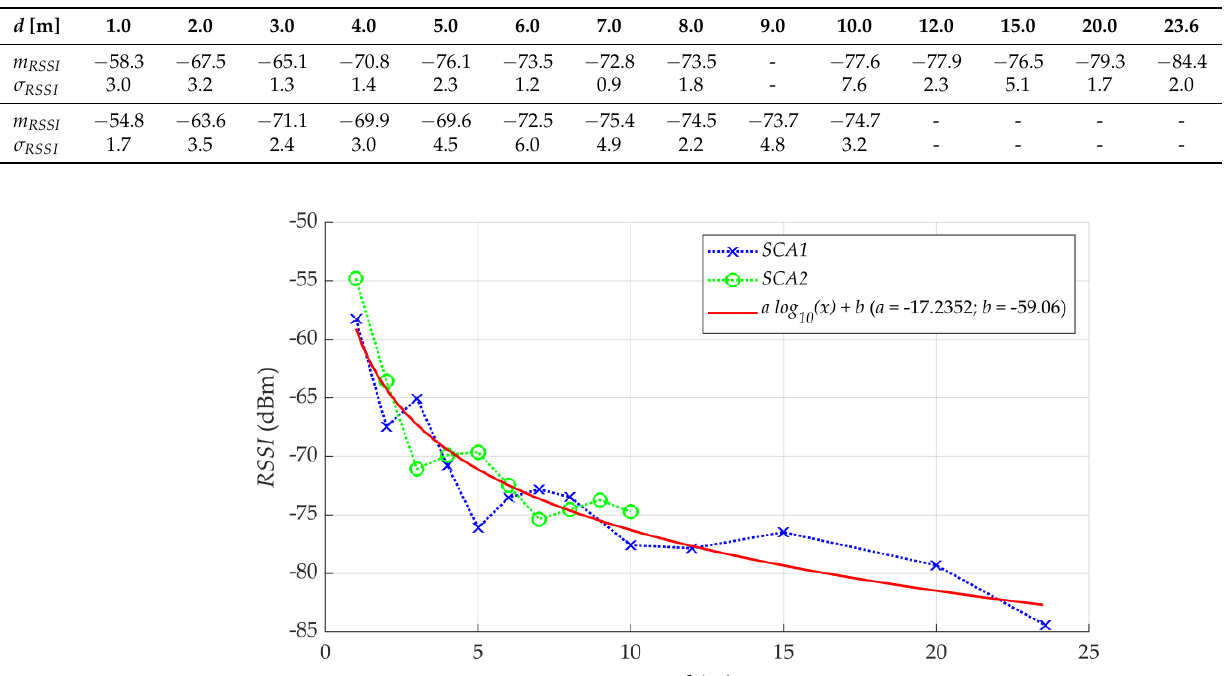
Table 1. The mean values ( m RSSI ) and standard deviations ( σ RSSI ) of the series of RSSI measurements performed according to the SCA1 and SCA2 test scenarios.